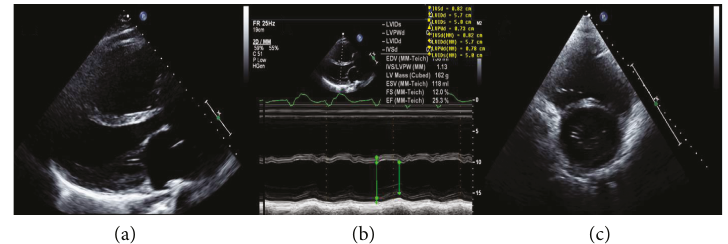
Figure 1: Echocardiogram: (a) parasternal long axis view showing right and left ventricular dilatation, (b) M-mode with left ventricular measurements, and (c) parasternal short axis view at mitral valve level with biventricular enlargement.